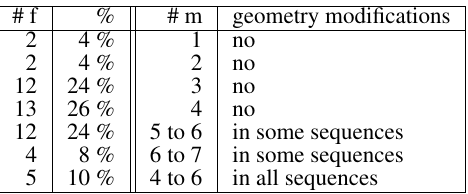
Table 2. Sizes and characteristics of clusters for the ”POI”